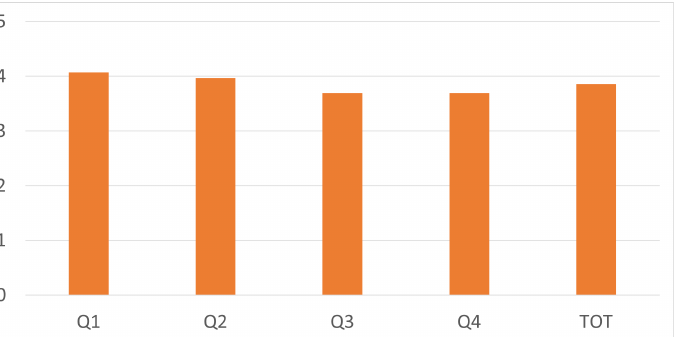
Figure 9. Mean results of the questionnaire on UE, provided at the end of the experiment, composed by of questions, with a score from 0 (low) to 5